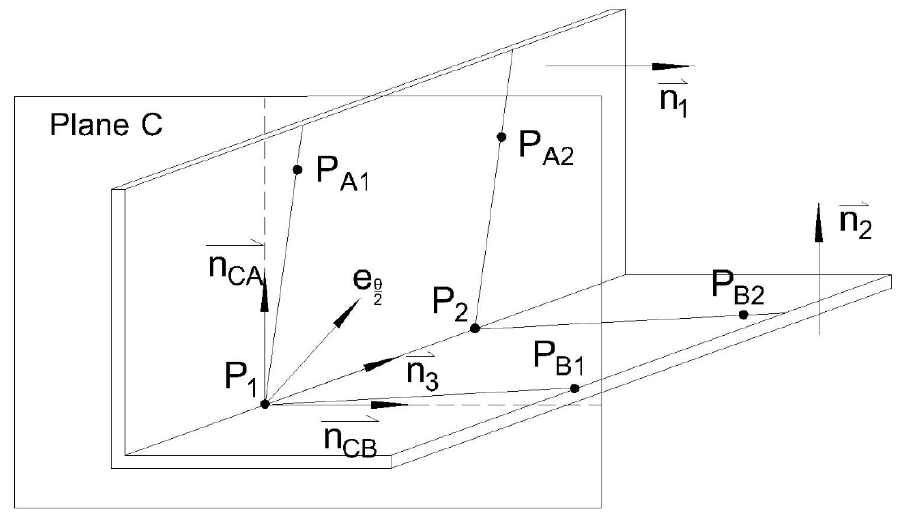
Figure 14. Mathematical model of the welding ‐ torch positioning.